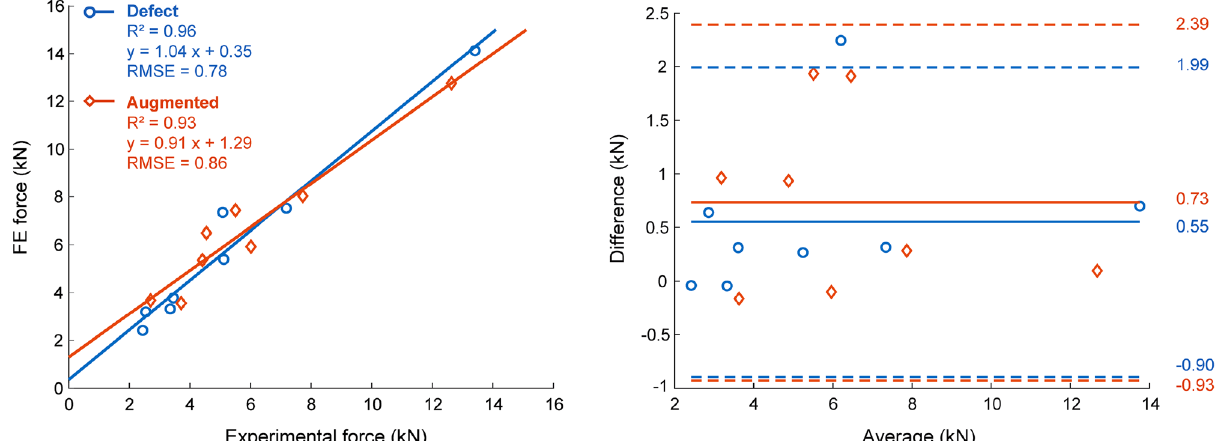
Figure 3. Validation failure force. A strong linear relation was found between the failure force quantified by FE and the experimental failure force, both for the defect and augmented group. Correlation graphs (left) and Bland–Altmann plots (right) are depicted.